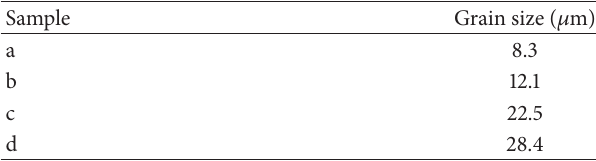
Table 2: The grain size of microwave sintered